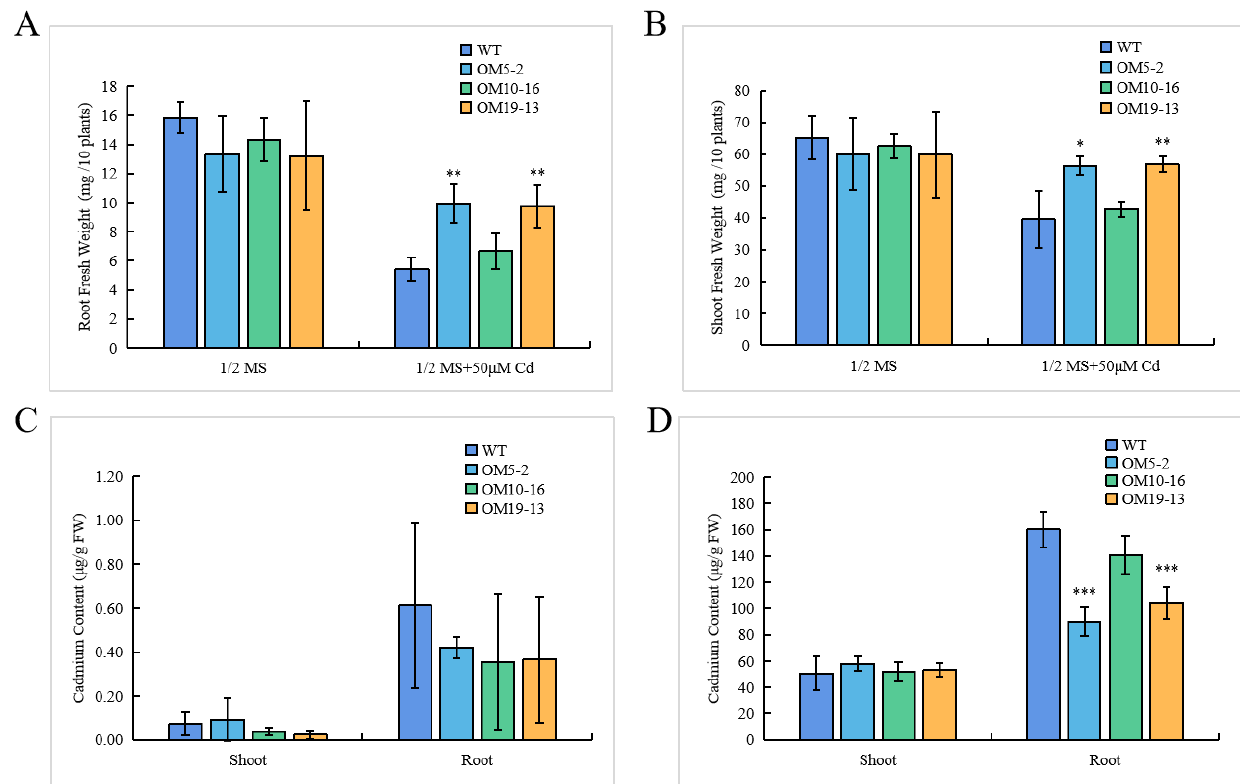
Figure 6. Seedlings weights and Cd contents of the WT and the PvHMA2.1 ectopically expressed lines in A. thaliana . ( A , B ) Fresh weights of roots ( A ) and shoots ( B ) in Arabidopsis seedlings grown on a 1/2 MS medium without Cd (as the control) or with 50 µ M of Cd for 8 days. ( C , D ) Cd contents in the shoots and roots of Arabidopsis seedlings grown on a 1/2 MS medium without Cd ( C ) and with 50 µ M of Cd ( D ) for 8 days. Cd contents were determined by using an inductively coupled plasma mass spectrometry (ICP-MS). The data represent the mean ± SD, n ≥ 3. Asterisks indicate significant differences compared to the WT: one asterisk indicates p < 0.05, two asterisks indicate p < 0.01, and three asterisks indicate p < 0.001.